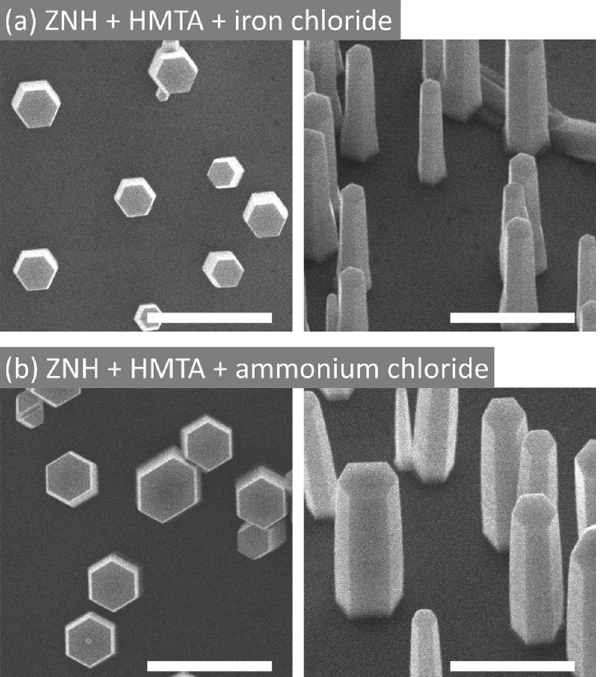
Figure 4. SEM images of ZnO MRs grown by using different chloride additives. Top- and tilt-view SEM images of MRs grown in the nutrient solution of ZNH and HMTA with an additive of ( a ) iron chloride and